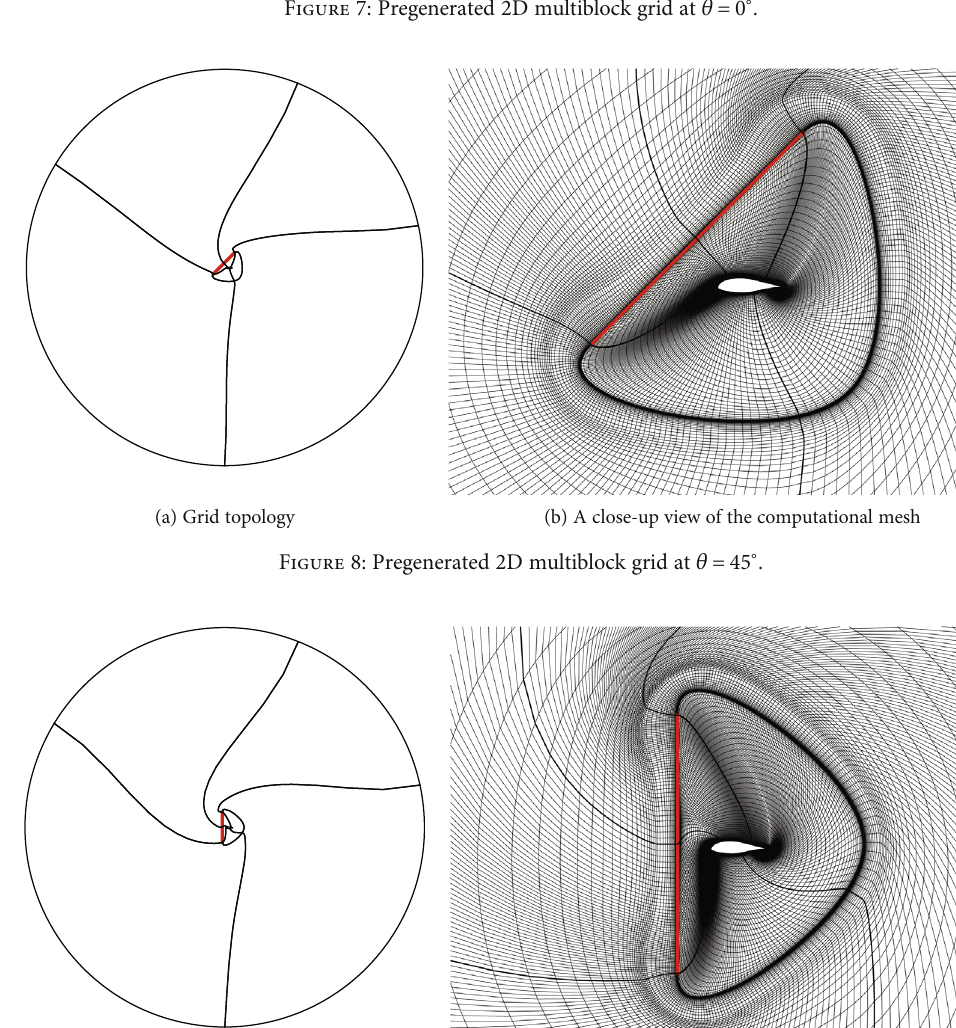
Figure 7: Pregenerated 2D multiblock grid at θ = 0 ° .